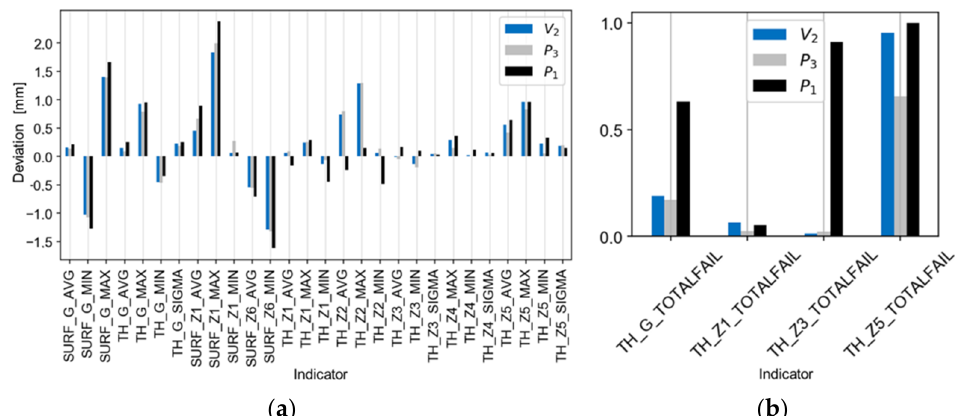
with the actual test results for the indicators of ( a ) deviations and of ( b ) tolerance.